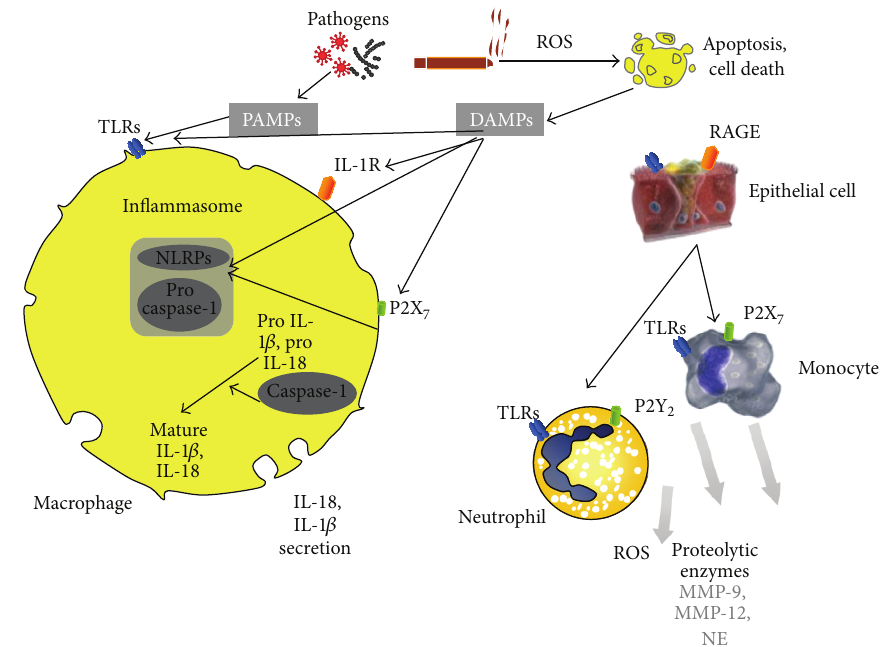
Figure 1: Inflammasome-associated inflammation in